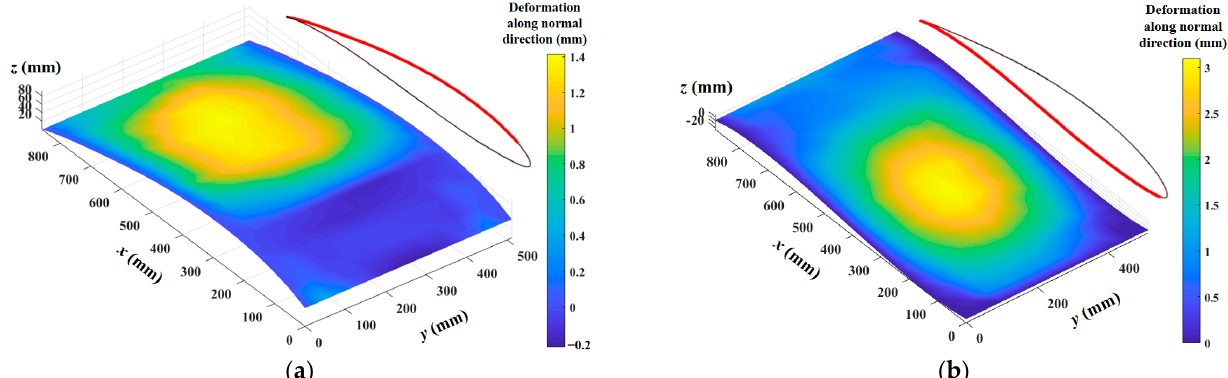
Figure 7. Membrane deformation measured by binocular vision system: ( a ) Upper surface; ( b ) Lower surface.